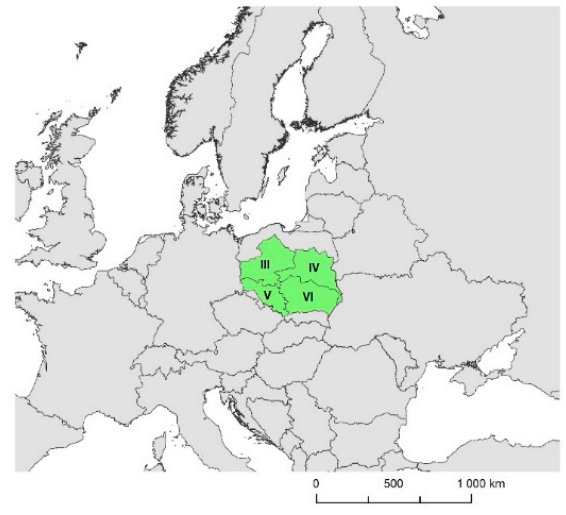
Figure 1. Location of the study area (green) on a map of Europe.